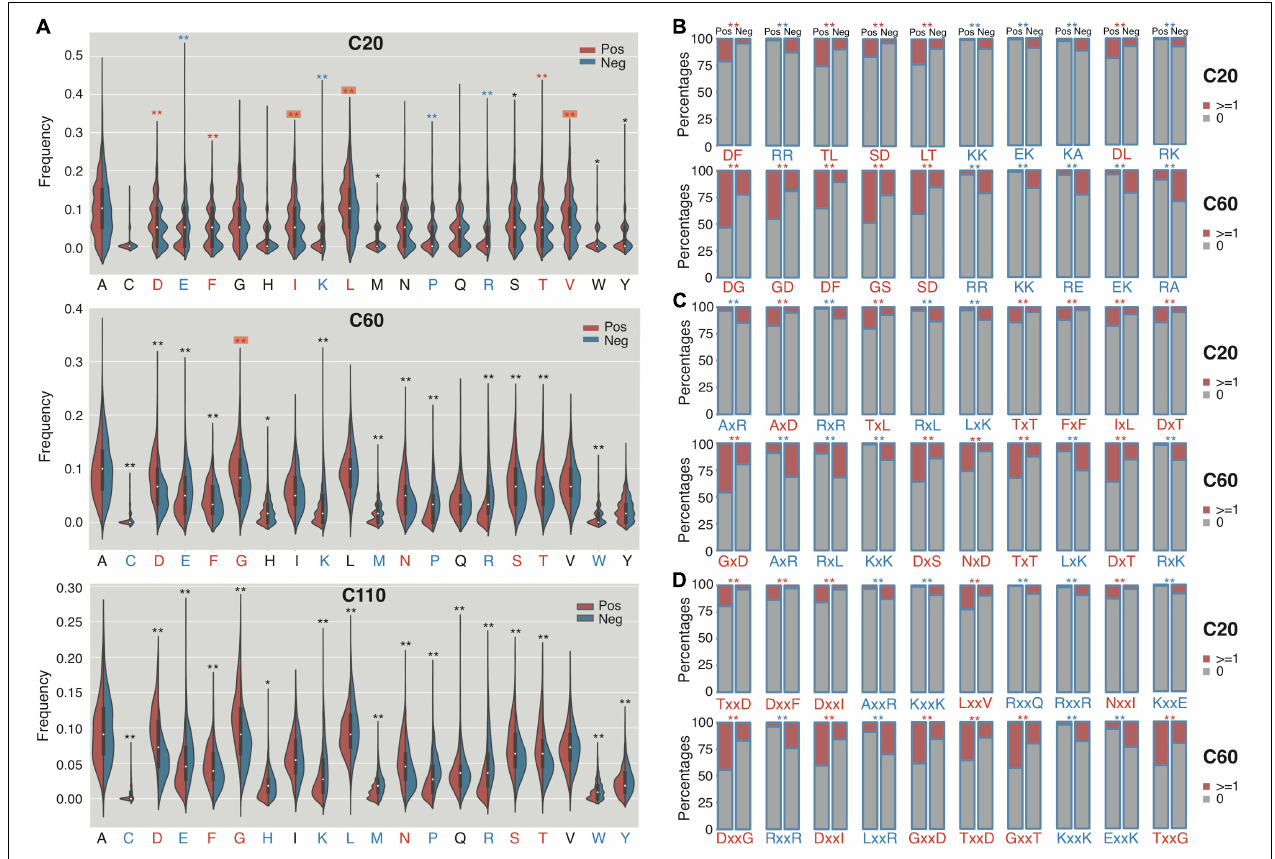
FIGURE 3 | The composition profile difference between the C termini of RTX and non-RTX proteins for single AAs, continuous and interrupted bi-AAs. (A) Single AAs. Bonferroni-corrected Mann–Whitney tests were performed. (B) Continuous bi-AAs. (C) One amino acid interrupted bi-AAs. (D) Two amino acids interrupted bi-AAs. EBT tests were performed for the bi-AAs. Most significantly enriched or depleted single AAs or bi-AAs in RTX C termini are shown in red and blue, respectively. The single AAs with biased composition changing among the C termini of different lengths are shown with red background. ** p < 0.0001, * p <